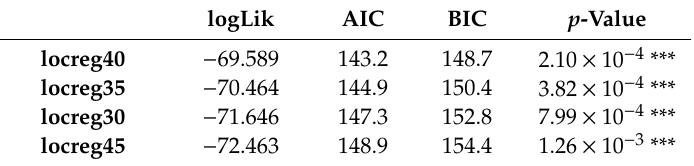
Table 4. Best models with one explanatory variable: Growth trend, ranked according to AIC value.